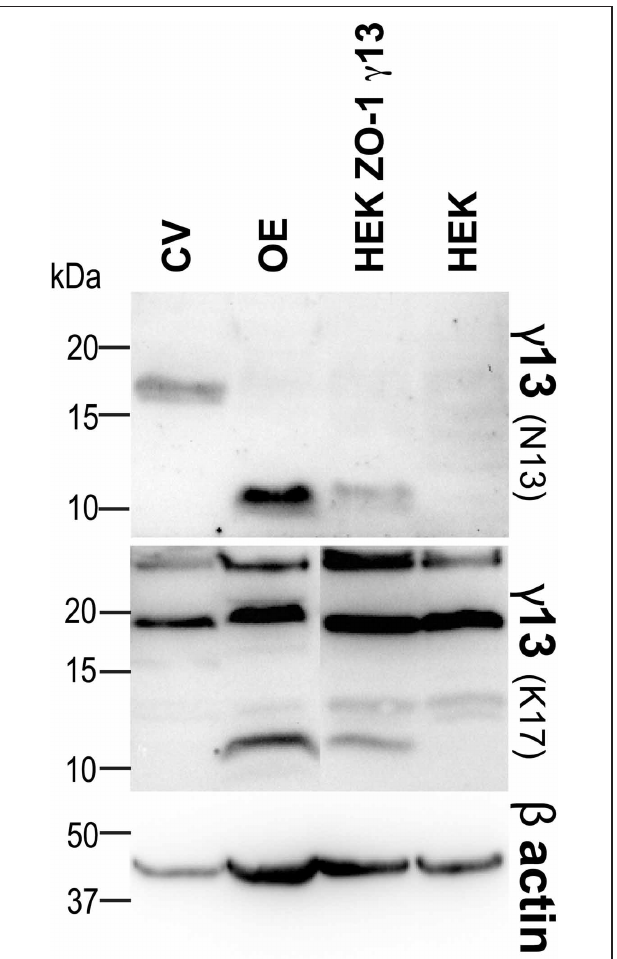
FIGURE A1 | Different features for G γ 13 in CV and OE. Immunodetection of G γ 13 protein in circumvallate (CV) and whole olfactory epithelium (OE) protein extracts. Protein extracts of HEK 293 cells (HEK) or HEK 293 cells stably expressing HA-G γ 13 transiently transfected with a full length Myc-ZO-1 construct (HEK ZO-1 γ 13) were used as controls. Note that G γ 13 displays a higher apparent molecular weight in CV than in OE or HEK ZO-1 γ 13 cells where the detected band runs at the predicted molecular mass (8kDa). An antibody raised against the N-terminal region of G γ 13 does not recognize G γ 13 in CV while it does in OE and HEK ZO-1 γ 13 cells. β -actin (42kDa) was used as loading control. The results presented are representative of two independent